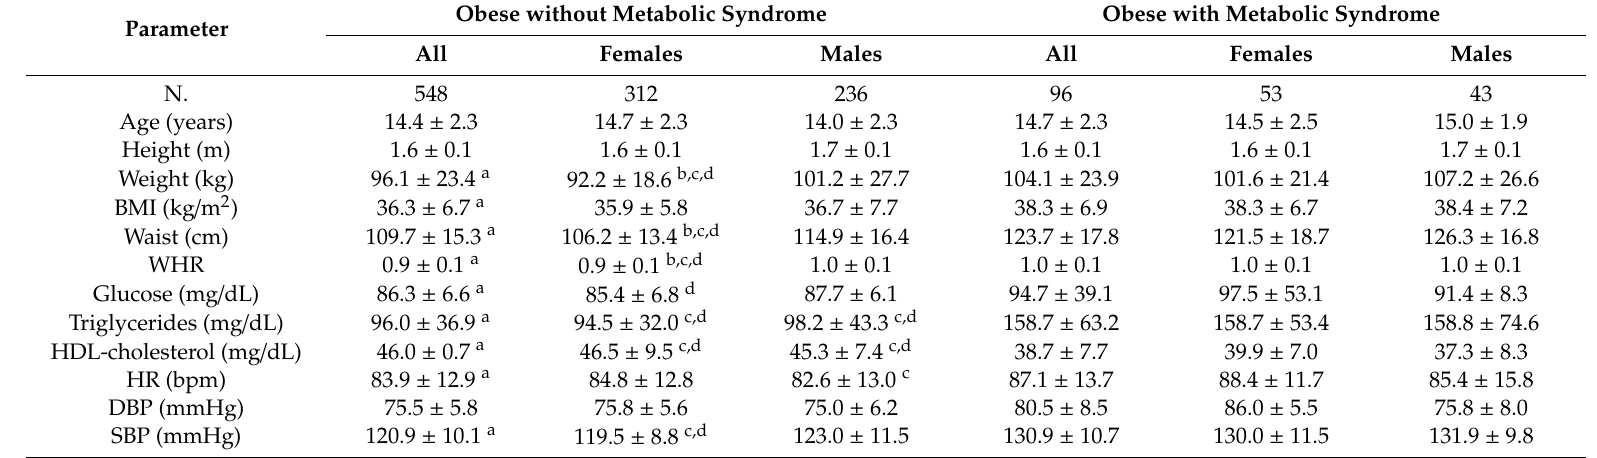
Table 1. Demographic, clinical and biochemical parameters of the recruited pediatric population, subdivided for metabolic syndrome (with / without) and sex (female /